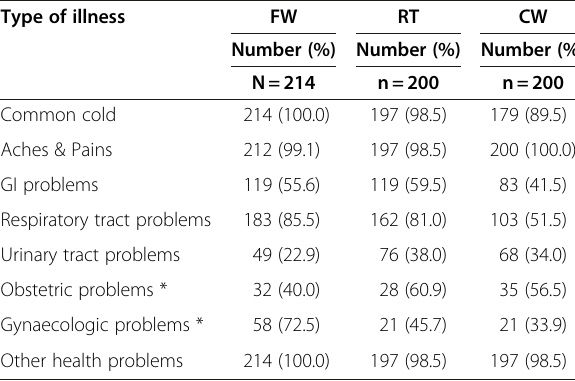
Table 2 Illnesses experienced by migrant workers while staying in Thailand by occupation Type of illness